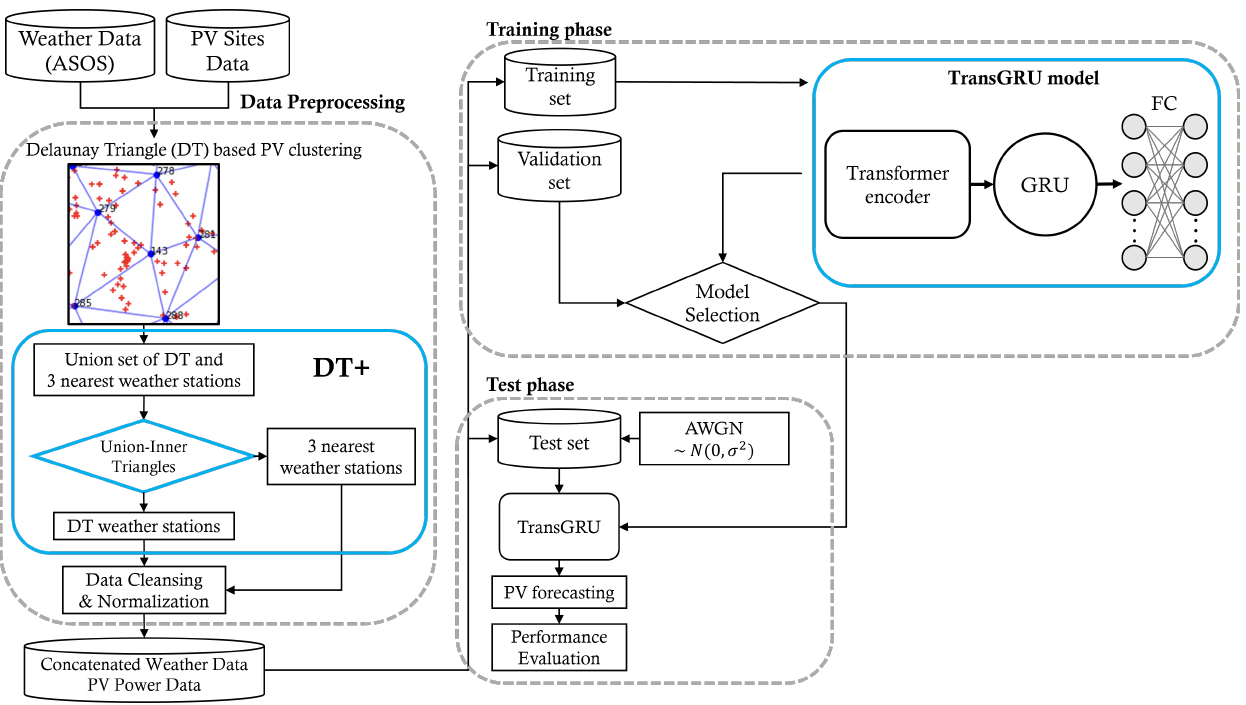
Figure 1. Overall process of the DTTrans